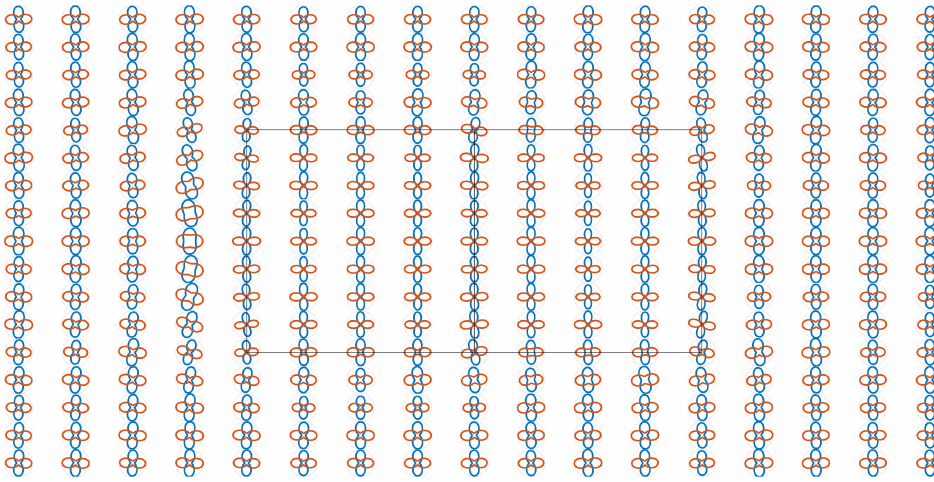
Figure 23. Polar plots of modified COMMEMI 3D-2A model for a frequency of 0.001